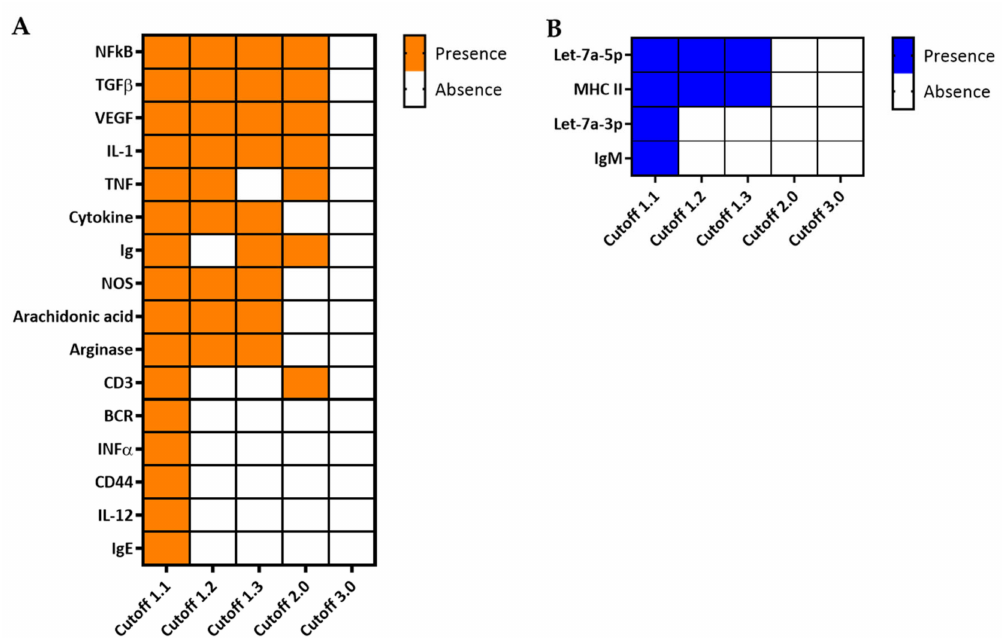
Figure 6. Key features identified in molecular networks relevant to immune/inflammatory processes in high-risk T1D subjects and the impact of the fold-change cutoff value on their identification. Comparison analysis in IPA software was applied to individual networks with scores at 10 or above, and key molecules were inferred based on curated integrated molecular networks generated at the indicated cutoff values (see Supplementary Figure S3). ( A ) Key molecules predicted to be activated in high-risk T1D subjects compared to healthy controls. Most prominent features, such as NF- κ B, TGF- β , VEGF, IL-1, and TNF, were consistently identified in networks predicted at all cutoff values ≤ 2.0; none were yielded at cutoff 3.0. ( B ) Key molecules that were predicted to be negatively regulated (inhibited) also decreased with increasing the threshold cutoff values. Orange color indicates features predicted as activated and blue color as